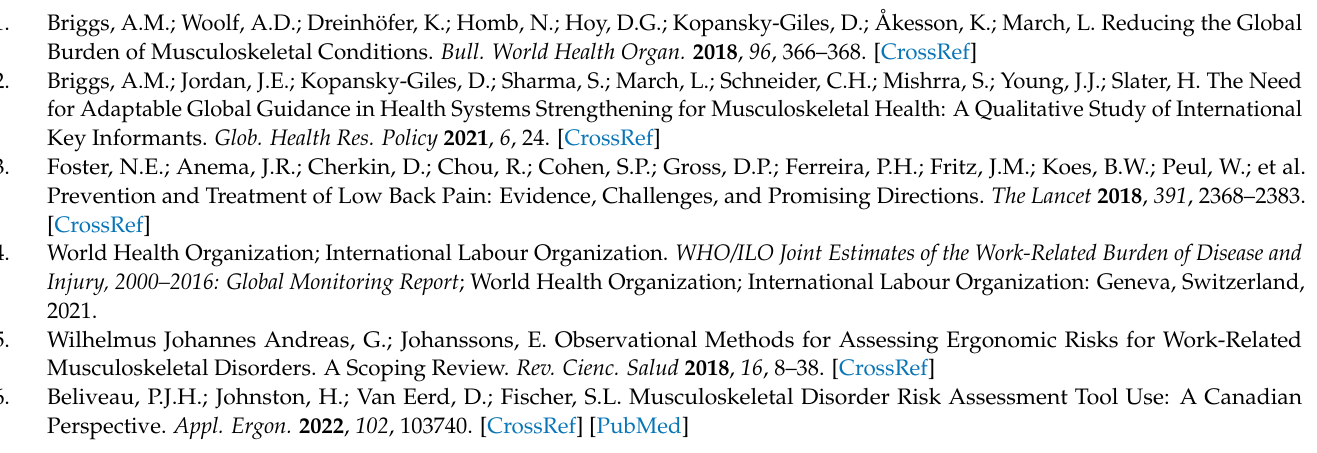
Table S2: Downs and Black study quality assessment scoring for eligible articles, prior to removal due to poor quality, Table S3: Characteristics of included studies: Characteristics included design, setting, description of MSI screening tool, study arm description, outcome measurements, and